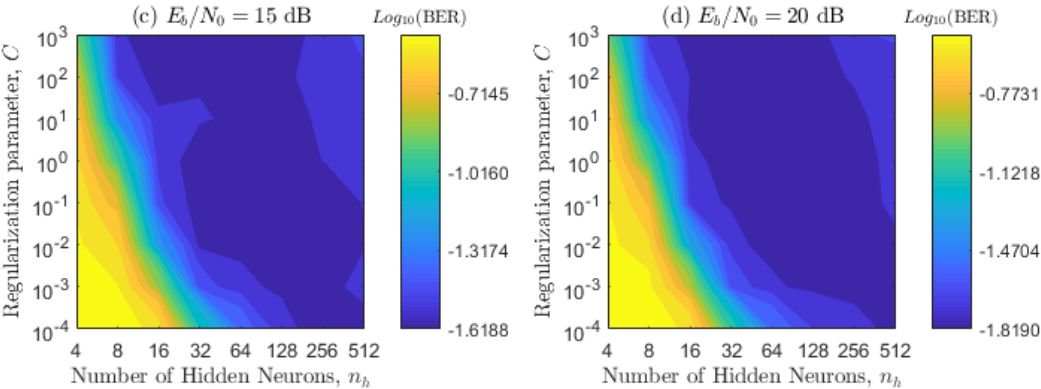
Figure 9. BER countour plot in terms of the regularization parameter C , number of hidden neurons, and different E b / N 0 values for system configuration